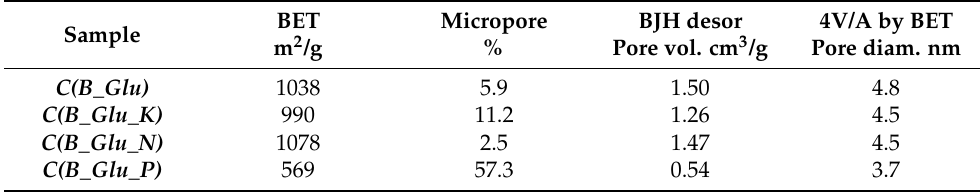
Table 2. Textural properties of the obtained